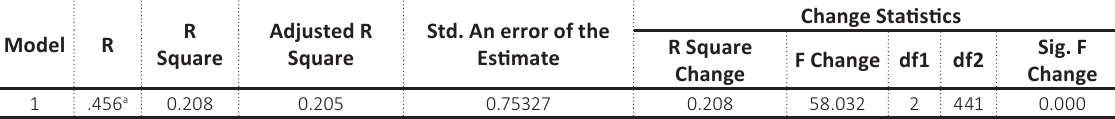
Table 7. Model summary for H